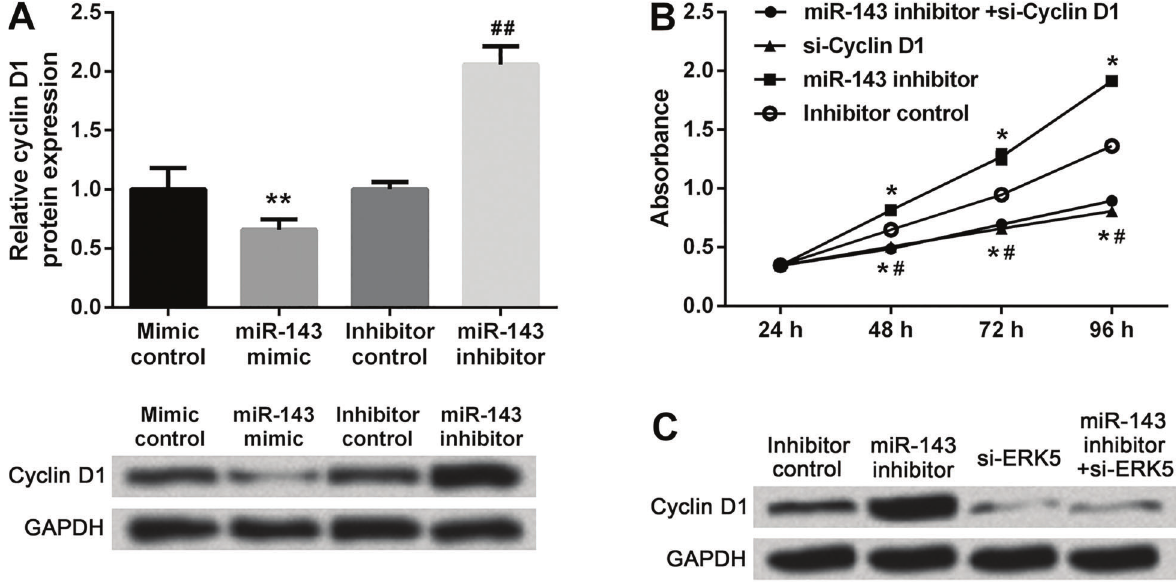
Figure 4. A , Cyclin D1 expression in cells transfected with mimic control, miR-143 mimic, inhibitor control or miR-143 inhibitor, detected by western blotting. **P o 0.01 compared with mimic control, ## P o 0.01 compared with inhibitor control (ANOVA). B , Cell viability in cells transfected with inhibitor control, si-cyclin D1, miR-143 inhibitor alone or accompanied by si-cyclin D1, detected by MTTassay. *P o 0.05 compared with inhibitor control, # P o 0.05 compared with miR-143 inhibitor (ANOVA). C , Cyclin D1 expression in cells transfected with inhibitor control, si-ERK5, miR-143 inhibitor alone or accompanied by si-ERK5. ERK5: extracellular signal-regulated kinase 5; si: small interfering RNA targeting. Data are reported as means ± SD of three independent experiments. Each experiment was repeated three times.